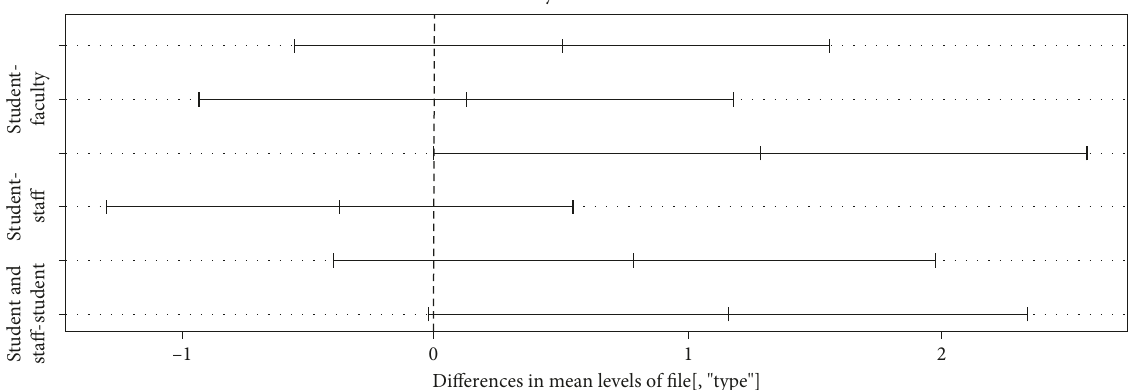
Figure 7: Difference of means between different groups